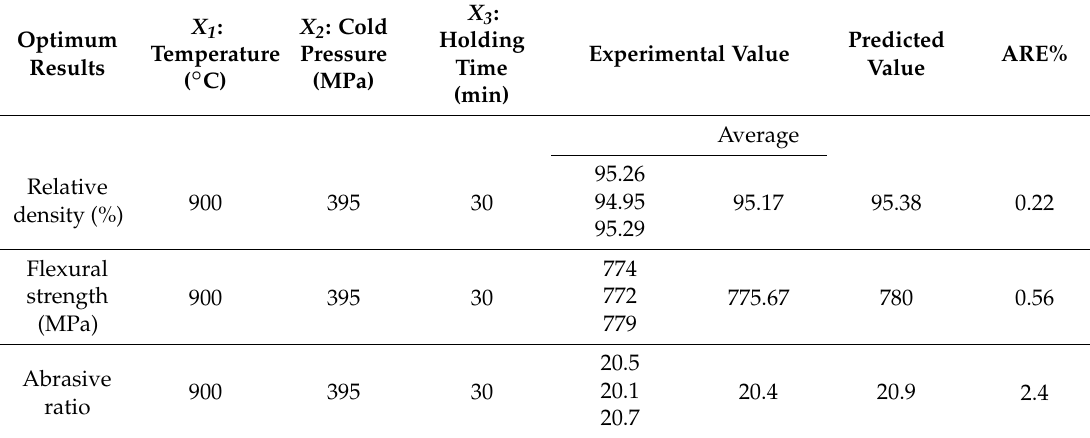
Figure 7. The response surface graph: the effect of sintering temperature, holding time, and cold pressure on the abrasive ratio of the sintered sample, ( a ) sintering temperature and holding time; ( b ) sintering temperature and cold pressure; ( c ) holding time and cold pressure. Table 7. Optimal condition values of microwave sintering conditions.